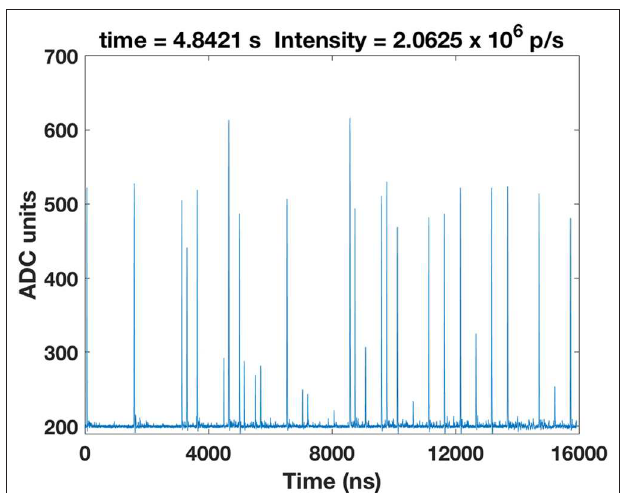
FIGURE 5 | Frame from an animation of the carbon ion spill course. Every frame in the Supplementary Video corresponds to a 16 µ s trace. The spill lasts approximately 4.85 s. Only the initial and the last part of the spill are displayed. The nominal intensity is I 1 = 2 × 10 6